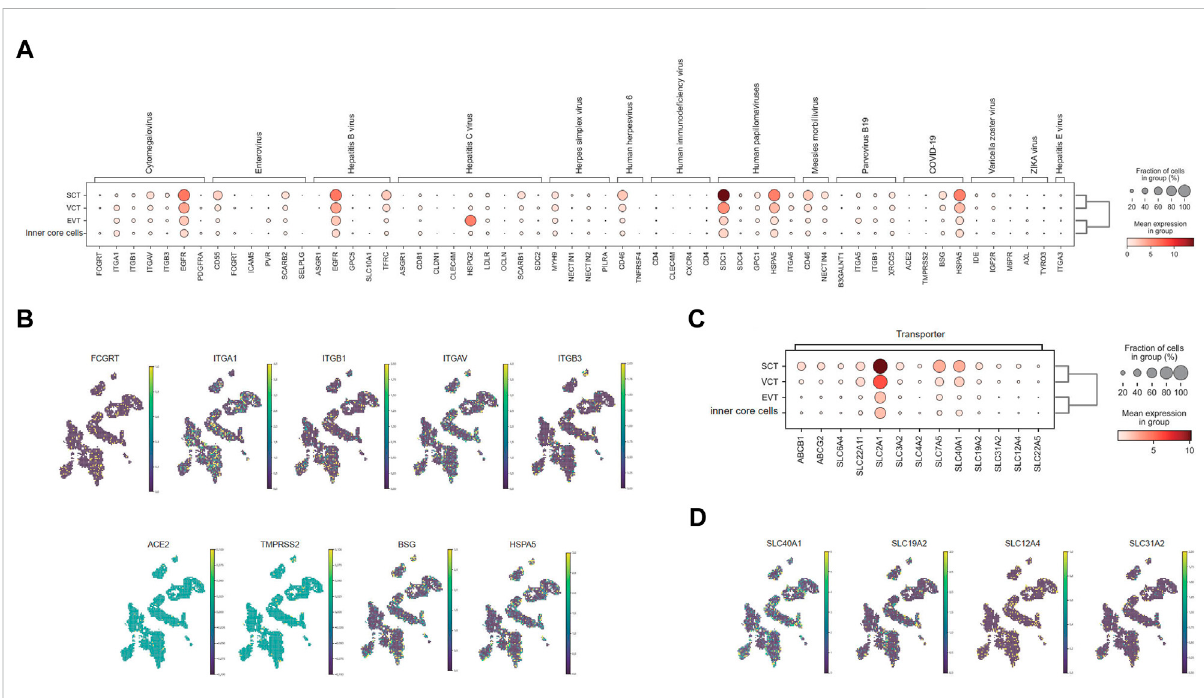
FIGURE 5 Distributionofvirusreceptorsanddrugtransportersinchorionicvilli. (A) Expressionlevelofreceptorsfordifferentvirusesinvilli. (B) Distribution of representative virus receptors. (C) Expression level of representative drug transporters in villi. (D) Distribution of representative drug